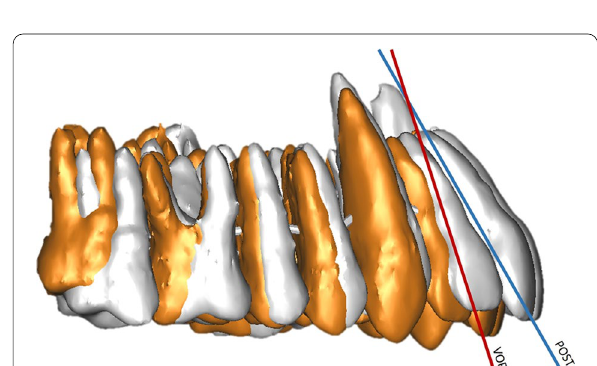
Fig. 11 Orthodontists set a positive torque on the central incisors to obtain a correct occlusal relationship